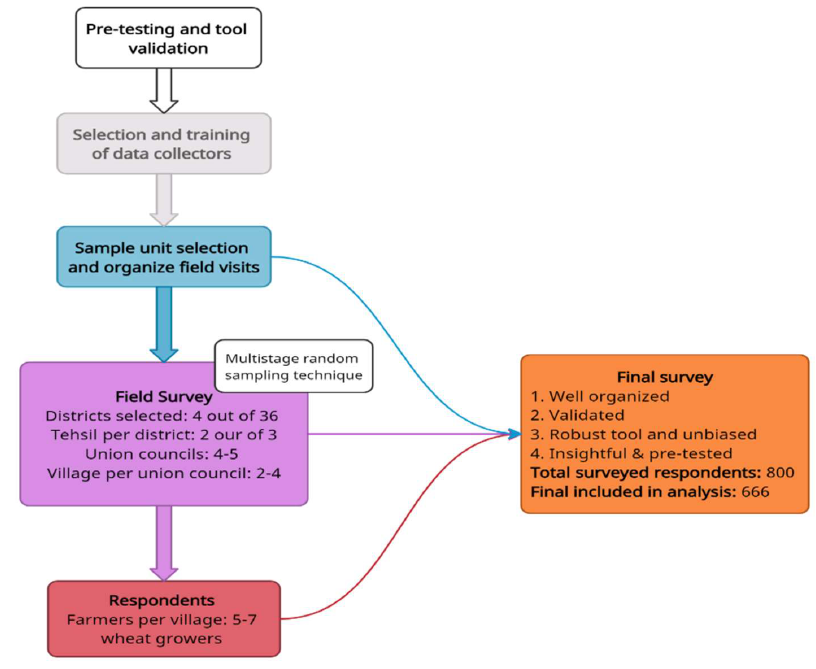
Figure 3. Sampling framework of the study.